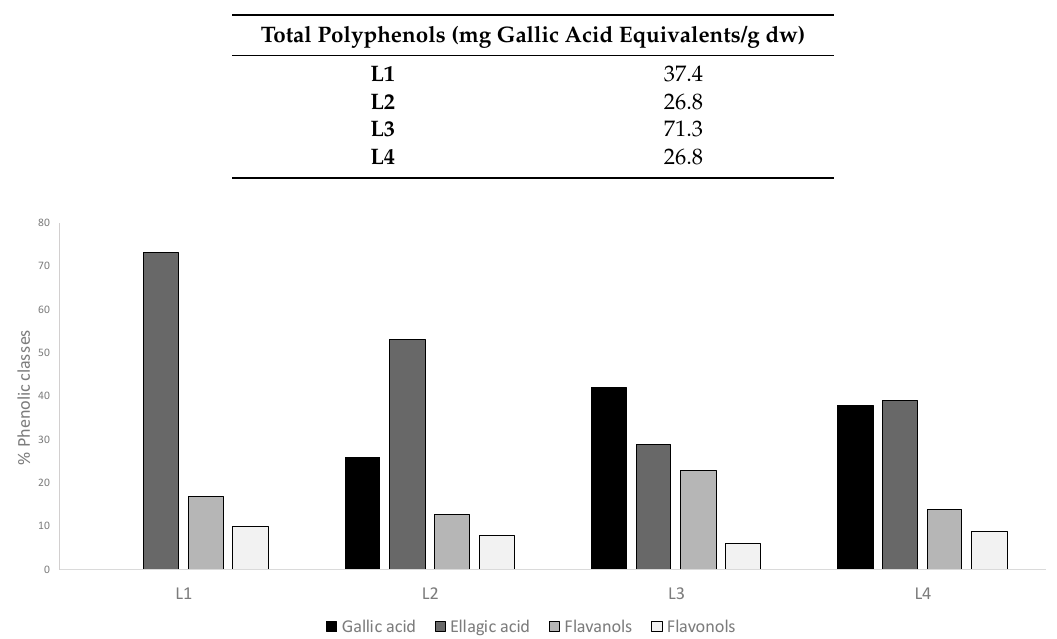
Table 1. Concentration of total phenolic compounds in the different grape pomace extracts.